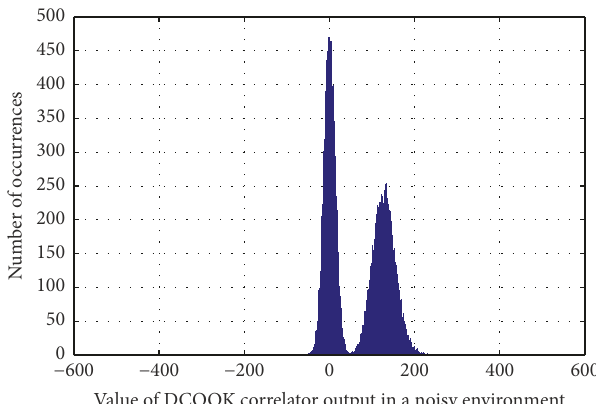
Figure 9: Histogram of noisy received signal at 𝐸 𝑏 /𝑁 𝑜 = 16 dB and 𝑀 = 100 .